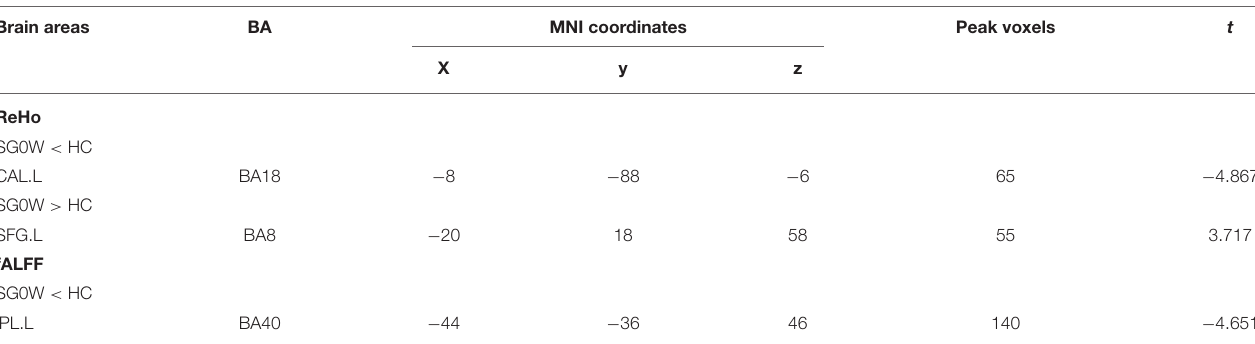
TABLE 2 | ReHo and fALFF differences between SG0W and